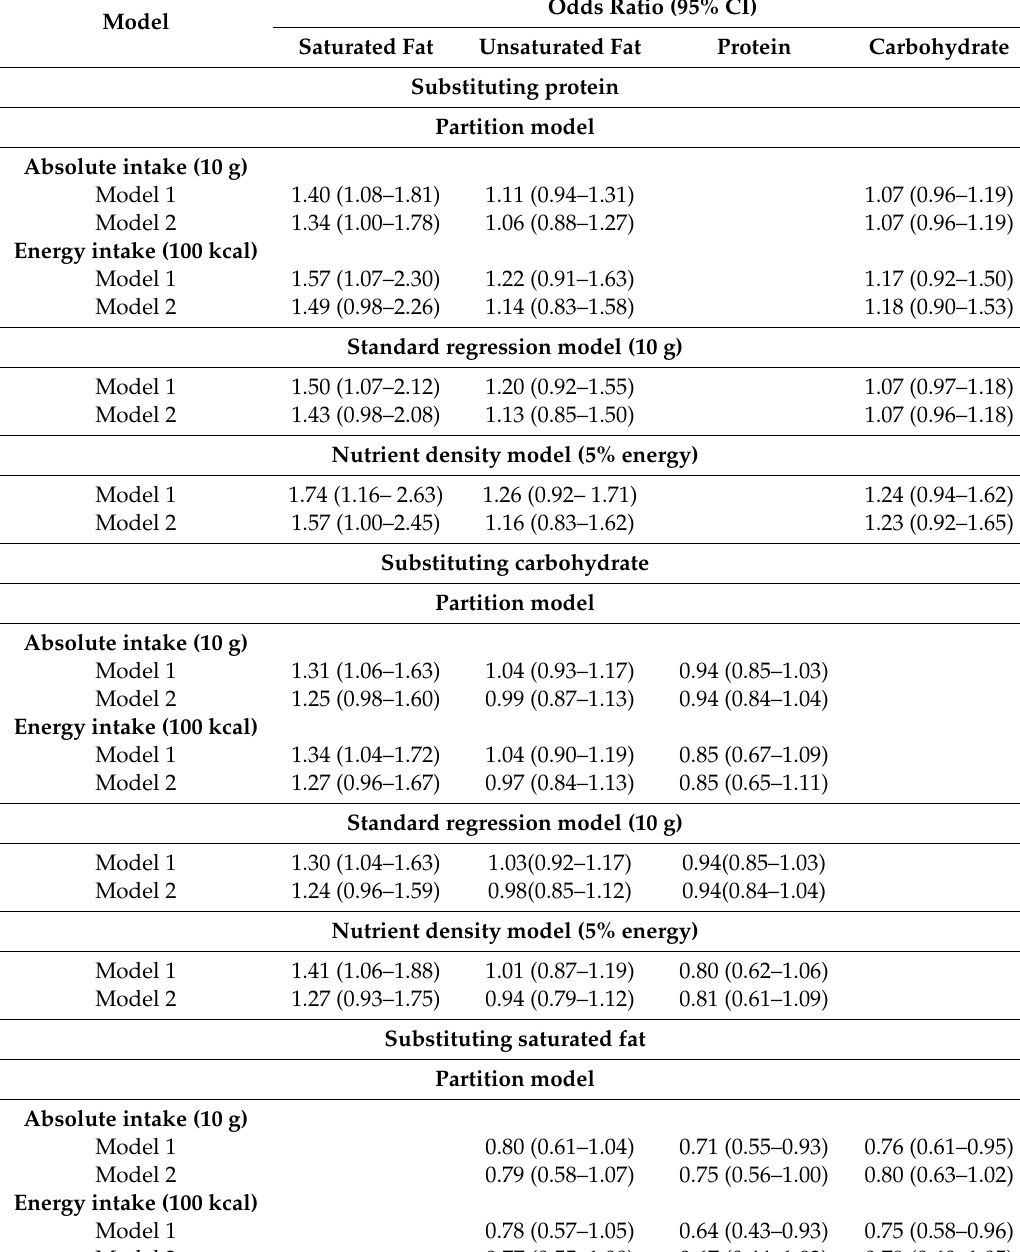
Table 3. Odds ratio (95% confidence intervals) for excessive daytime sleepiness associated with decrease of 10 g, 100 kcal or 5% per day of one of the macronutrients and simultaneous increase of 10 g, 100 kcal or 5% per day of other macronutrients in the North West Adelaide Health